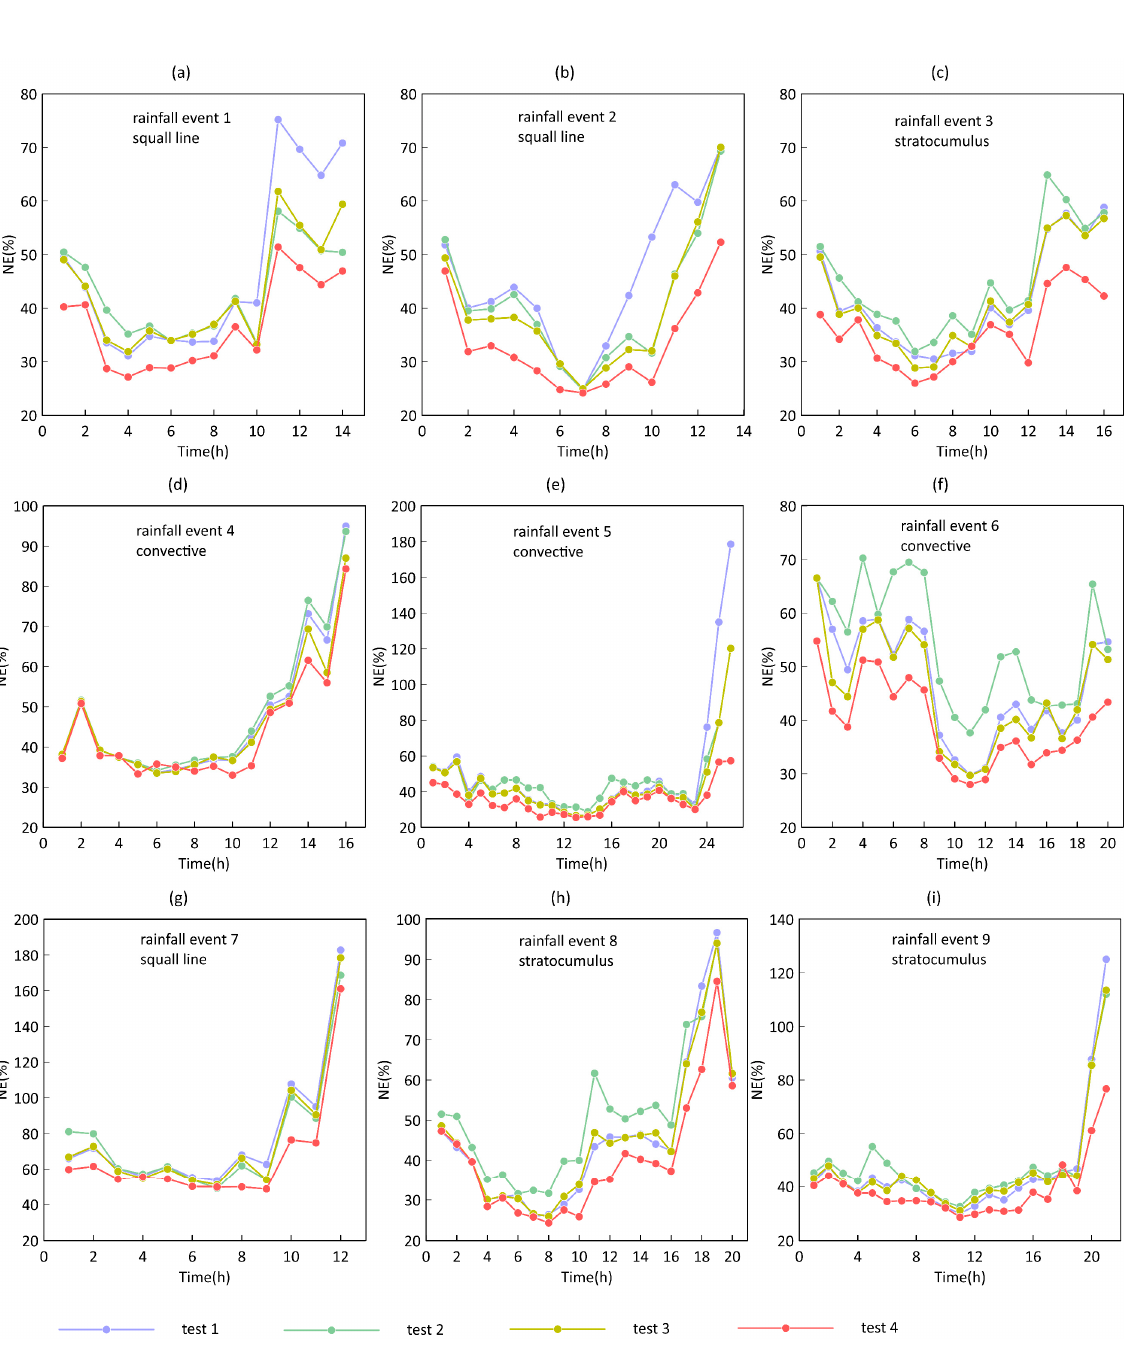
Figure 5. ( a – i ) Time series of NE values for the rainfall event 1–9. The QPE performance at CRQI > 0.9 was evaluated. The purple, green, yellow, and red lines represent NE values in tests 1, 2, 3, and 4, respectively.